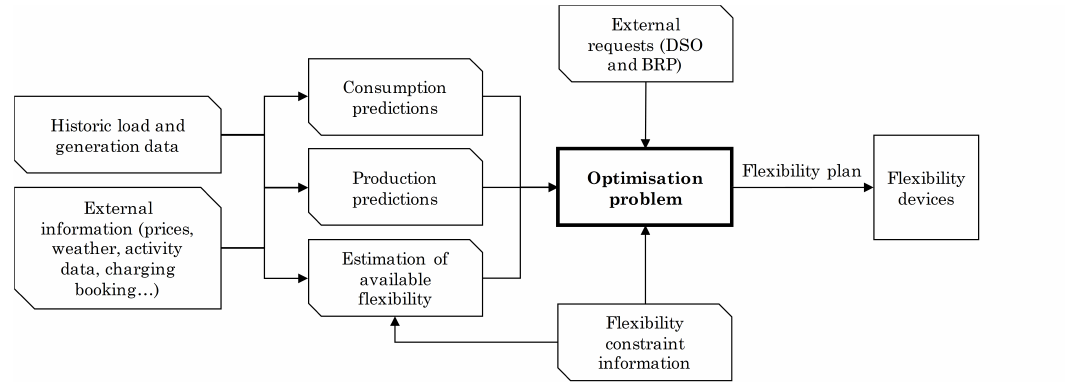
Figure 7. Local flexibility market algorithm.